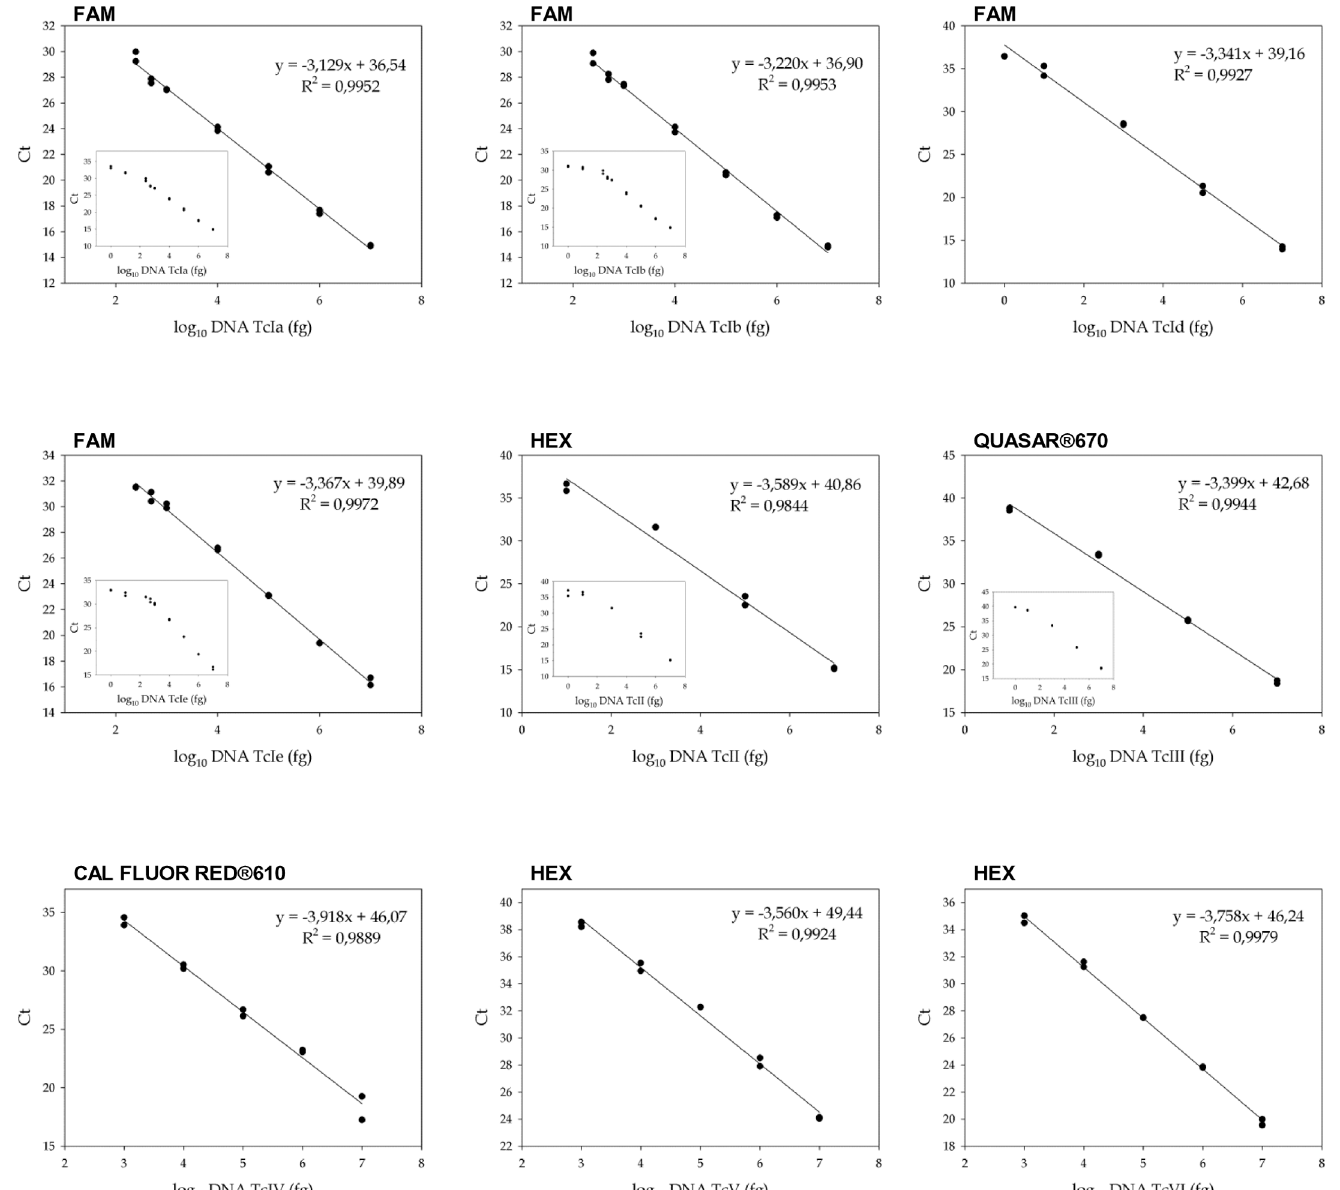
Fig 2. Linear range and analytical sensitivity of the first round SL-IR MTq PCR for T . cruzi DTUs and TcI SL-IR genotypes. X-axis represents serial dilutions of whole genomic DNA from each stock and Y-axis represents the obtained Ct value. Linear regression analysis, equation and R 2 are shown for each graph. Inserts inside plots represent the Ct values obtained for the complete DNA concentration range tested (1 fg — 10 ng/ reaction tube). TcIa, strain K98; TcIb, strain Cas16; TcId, strain G; TcIe, strain PALV1 cl1; TcII, strain Tu18; TcIII, strain M5631; TcIV, strain CanIII; TcV, strain PAH265; and TcVI, strain CL